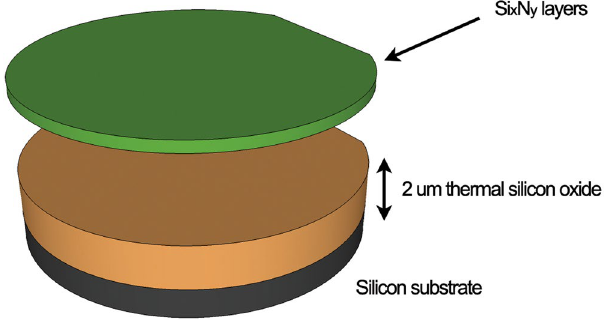
Figure 1. Schematic representation of the wafer composition.